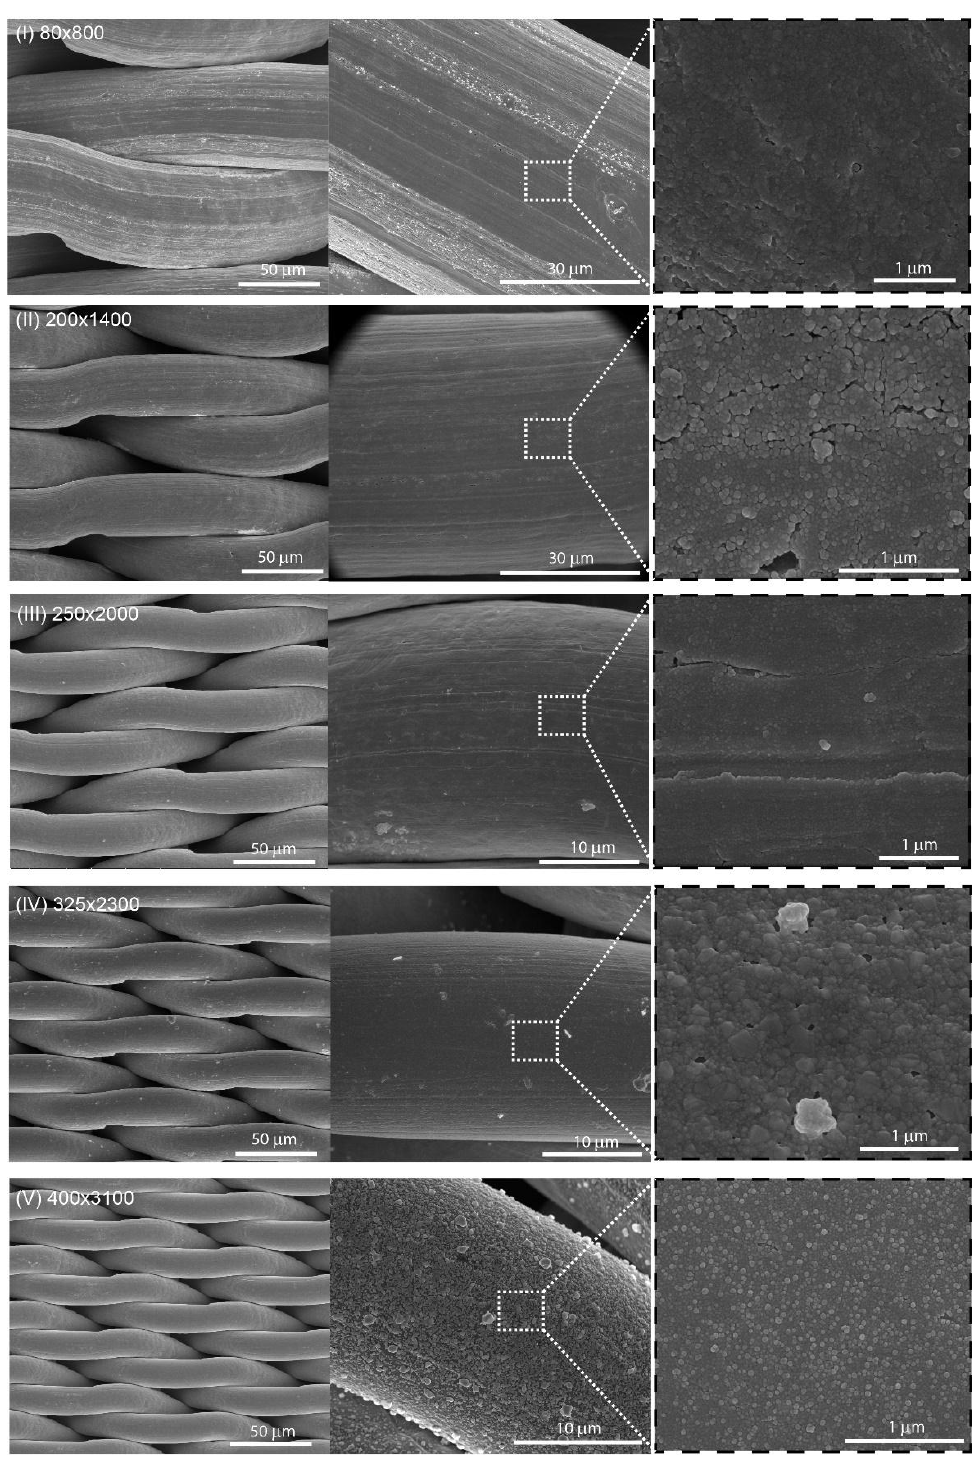
Figure 3. SEM images of SERS-active platforms (sputtered with 50 nm layer of silver via PVD technique) at three different magnifications. Parameters of the wire meshes are described in Table 1.